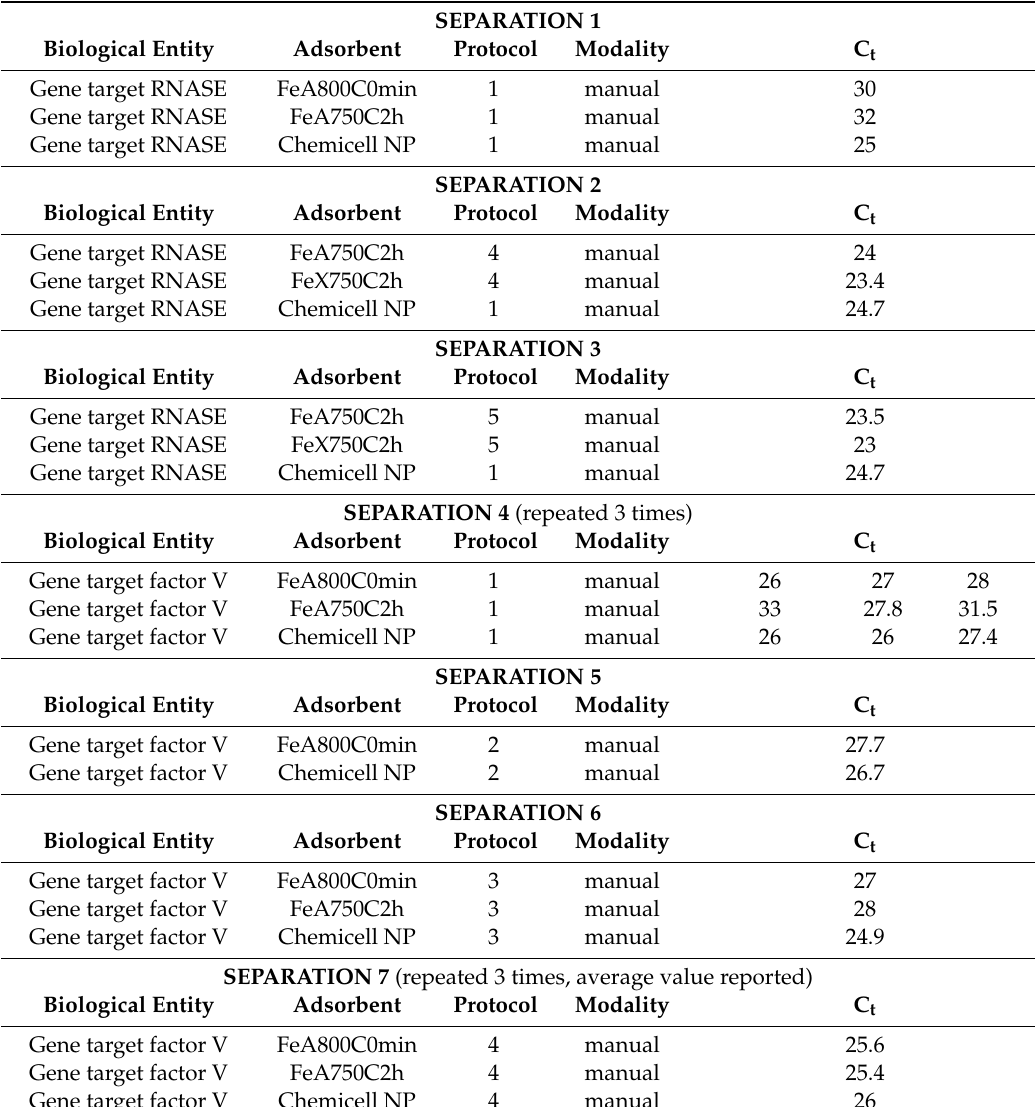
Table 3. Summary of the performed biological separations and obtained results. SEPARATION